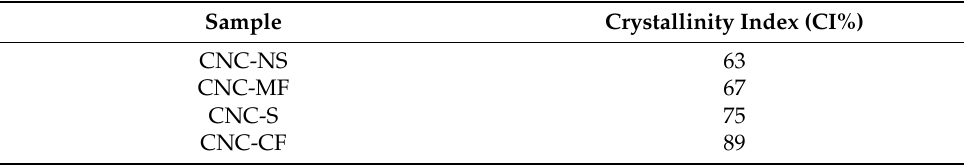
Table 4. Crystallinity index (CI%) of CNCs calculated with the Segal method.